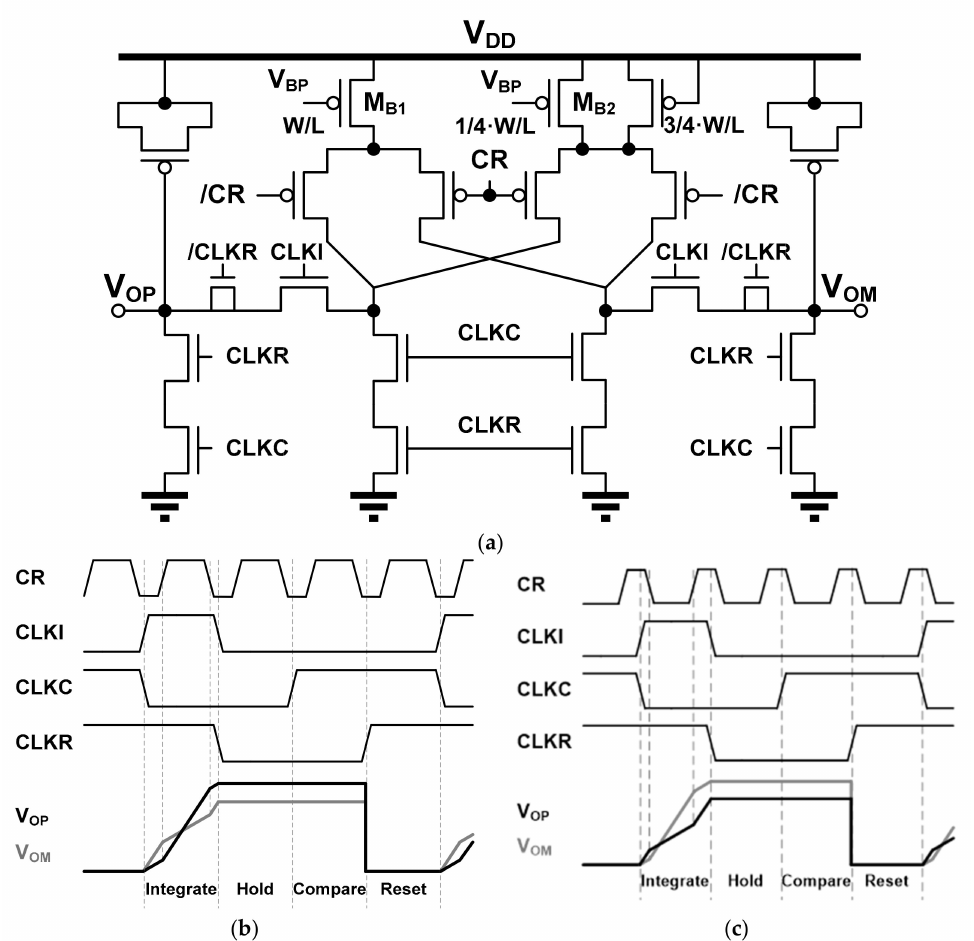
Figure 10. Current integrator: ( a ) Circuit diagram; ( b ) Output waveforms for CR with duty cycle ratio greater than 50%; ( c ) Output waveforms for CR with duty cycle ratio less than